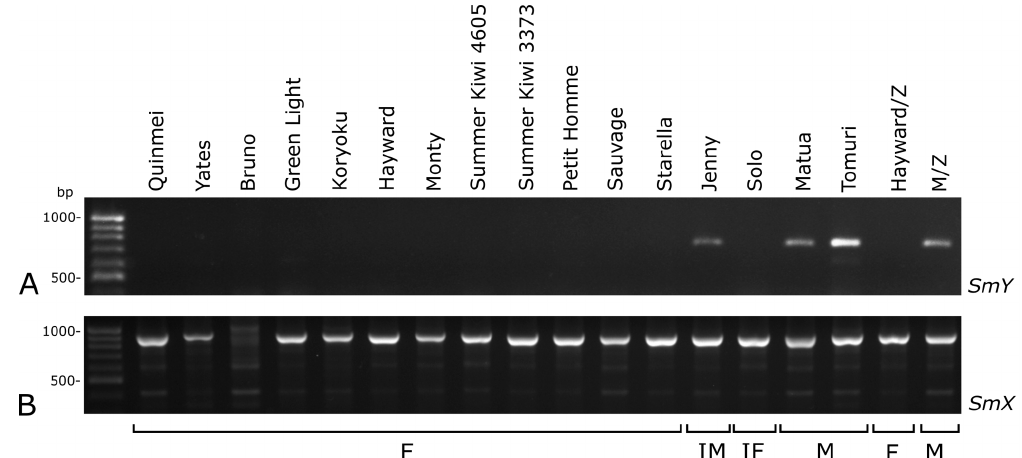
Figure 3. Amplification bands of SmY ( A ) and SmX ( B ) in selected cultivars of Actinidia chinensis var. deliciosa . Hayward/Z and M/Z indicate cv. Hayward and a male pollinator obtained from Zespri International Ltd. F—female, IF—inconsistent female, IM—inconsistent male, M—male.